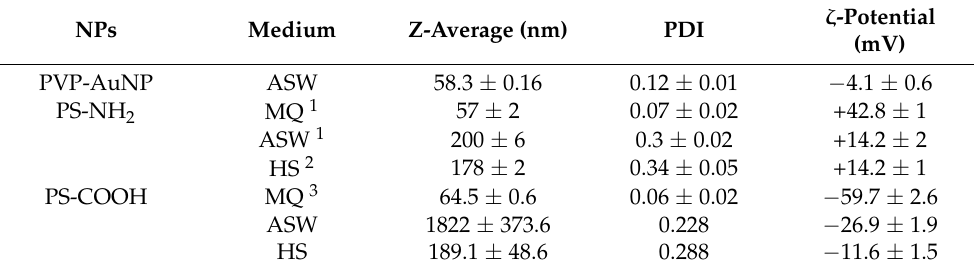
Table 1. Physicochemical characterization of NPs tested in vitro, PVP-AuNP, nanopolystyrenes (PS-NH 2 and PS-COOH) behavior in exposure